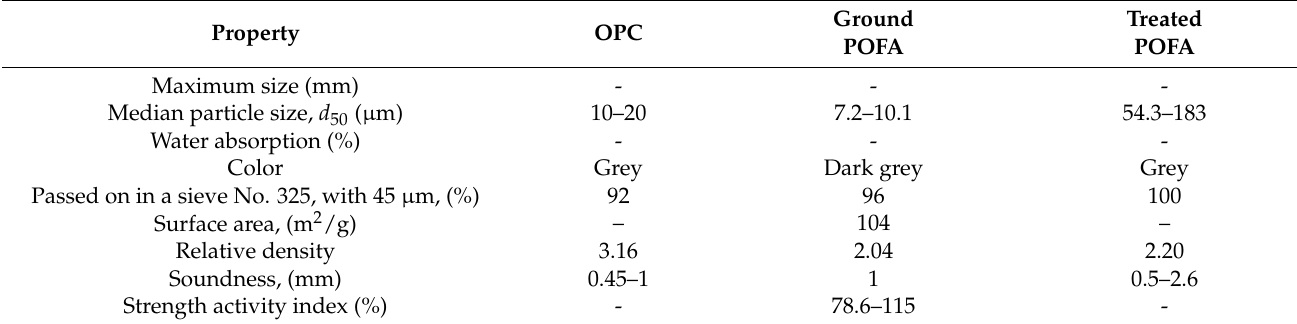
Table 2. Physical properties of OPC, treated POFA, and ground POFA